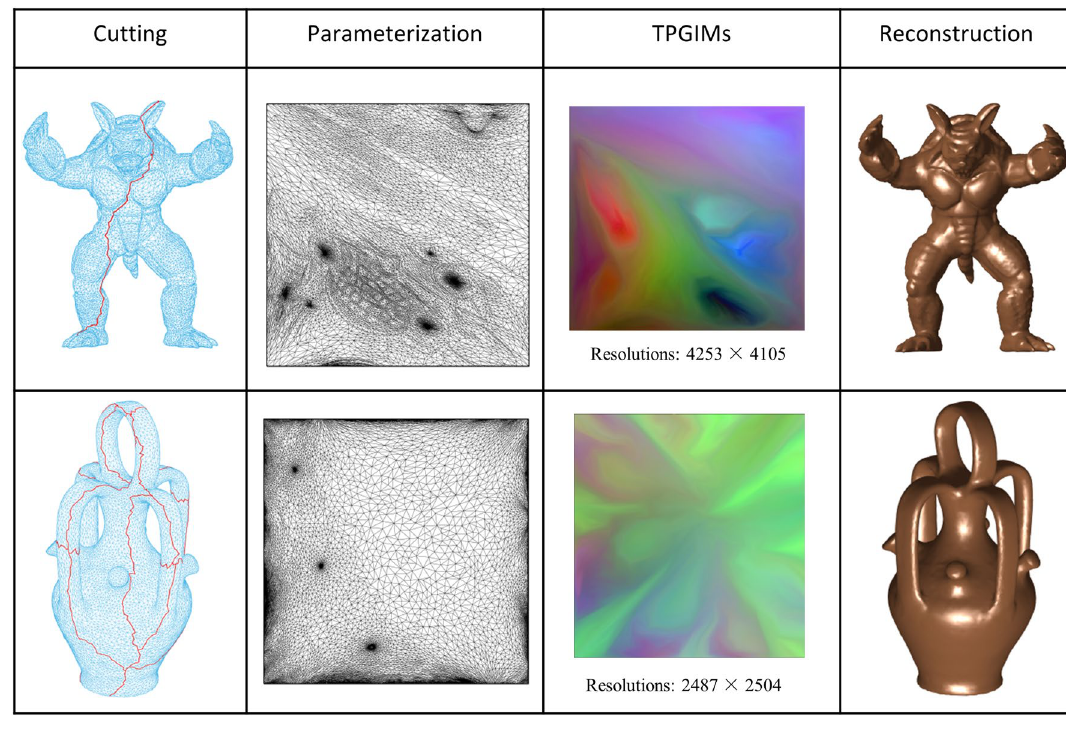
Figure 1. 3D models and its TPGIMs.